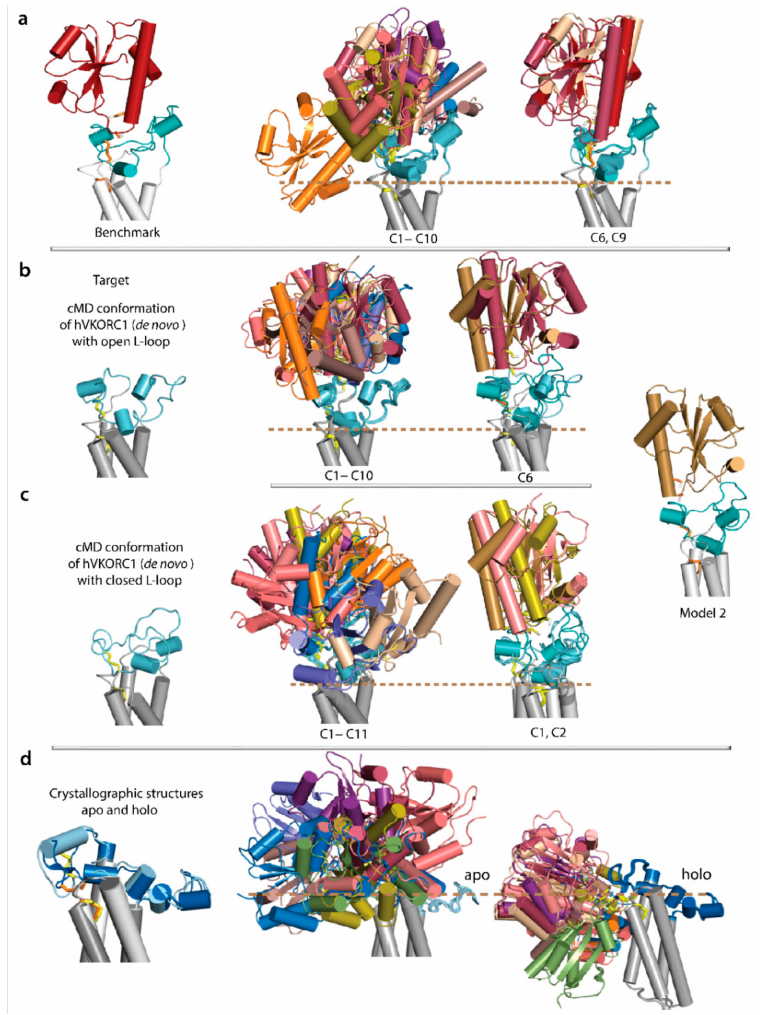
Figure 10. Computational protein–protein docking of PDI (ligand) onto hVKORC1 (target) performed with HADOCK using an information-driven method. ( a ) Benchmark complex from [15] (left); superimposition of the top 10 solutions (middle) and best solutions, clusters C6 and C9, (right) on benchmark. ( b , c ) (Left) hVKORC1 conformations with different L-loop shapes, elongated (open, b ) and compact (closed, c ) conformations in de novo model [14]. (Middle) Superimposition of the top solutions obtained for hVKORC1 with closed ( b ) and open ( c ) L-loop conformations. (Right) Model 2 suggested as possible in [15] used for superimposition of HADDOCK solutions, cluster C6, and C1 and C2 obtained for hVKORC1 with open ( b ) and closed ( c ) L-loop conformations. Two orthogonal projections are shown. ( d ) hVKORC1 homology models, apo-h, and holo-h, quasi-identical to X-ray structures (PDB IDs: 6wv3 and 6wvi) (left). Superimposition of the top of 10 HADDOCK solutions for PDI docked onto apo-h (middle) and holo-h (right) forms of hVKOR. ( a – d ) Protein is shown as a cartoon with helices as cylinders and disulfide bridges in yellow sticks. A possible boundary of the membrane is denoted as dashed